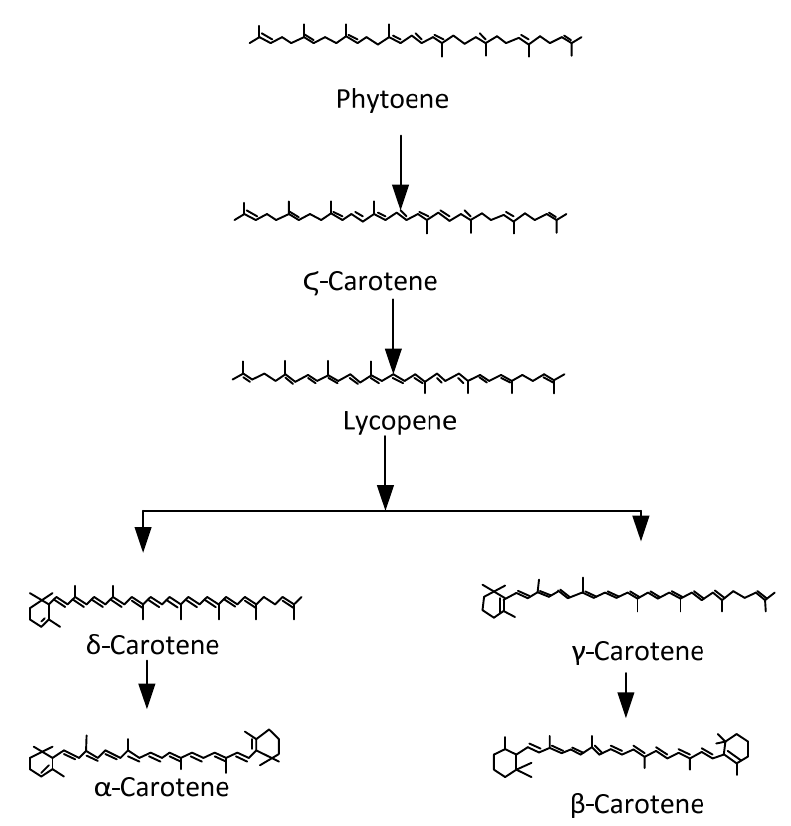
Figure 4. Simplified route of lycopene biosynthesis [39].